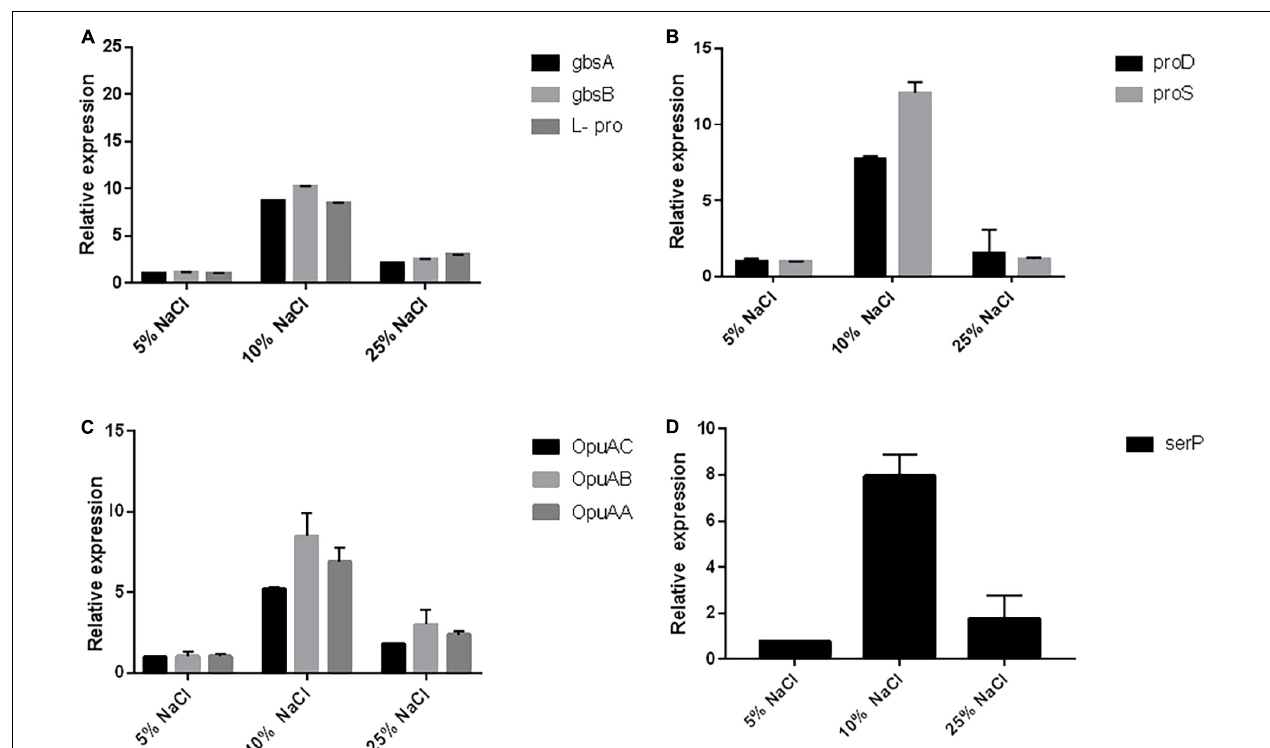
FIGURE 6 | RT-PCR reveals the upregulation of the pathways related to osmotic stress. (A) Represents the qRT-PCR of the genes responsible for the glycine, betain, and proline biosynthesis (gbcA, gbcB, and L -pro). Similarly, (B) represents the qRT-PCR genes involved in the biosynthesis of L -hydroxyproline (proD and proS), (C) represents the qRT-PCR of genes related to glycine betain transporter subunits (OpuAC, OpuAA, and OpuAB), and (D) represents qRT-PCR of the genes involved in the stress response proteolysis gene for periplasmic membrane stress sensing (serP).